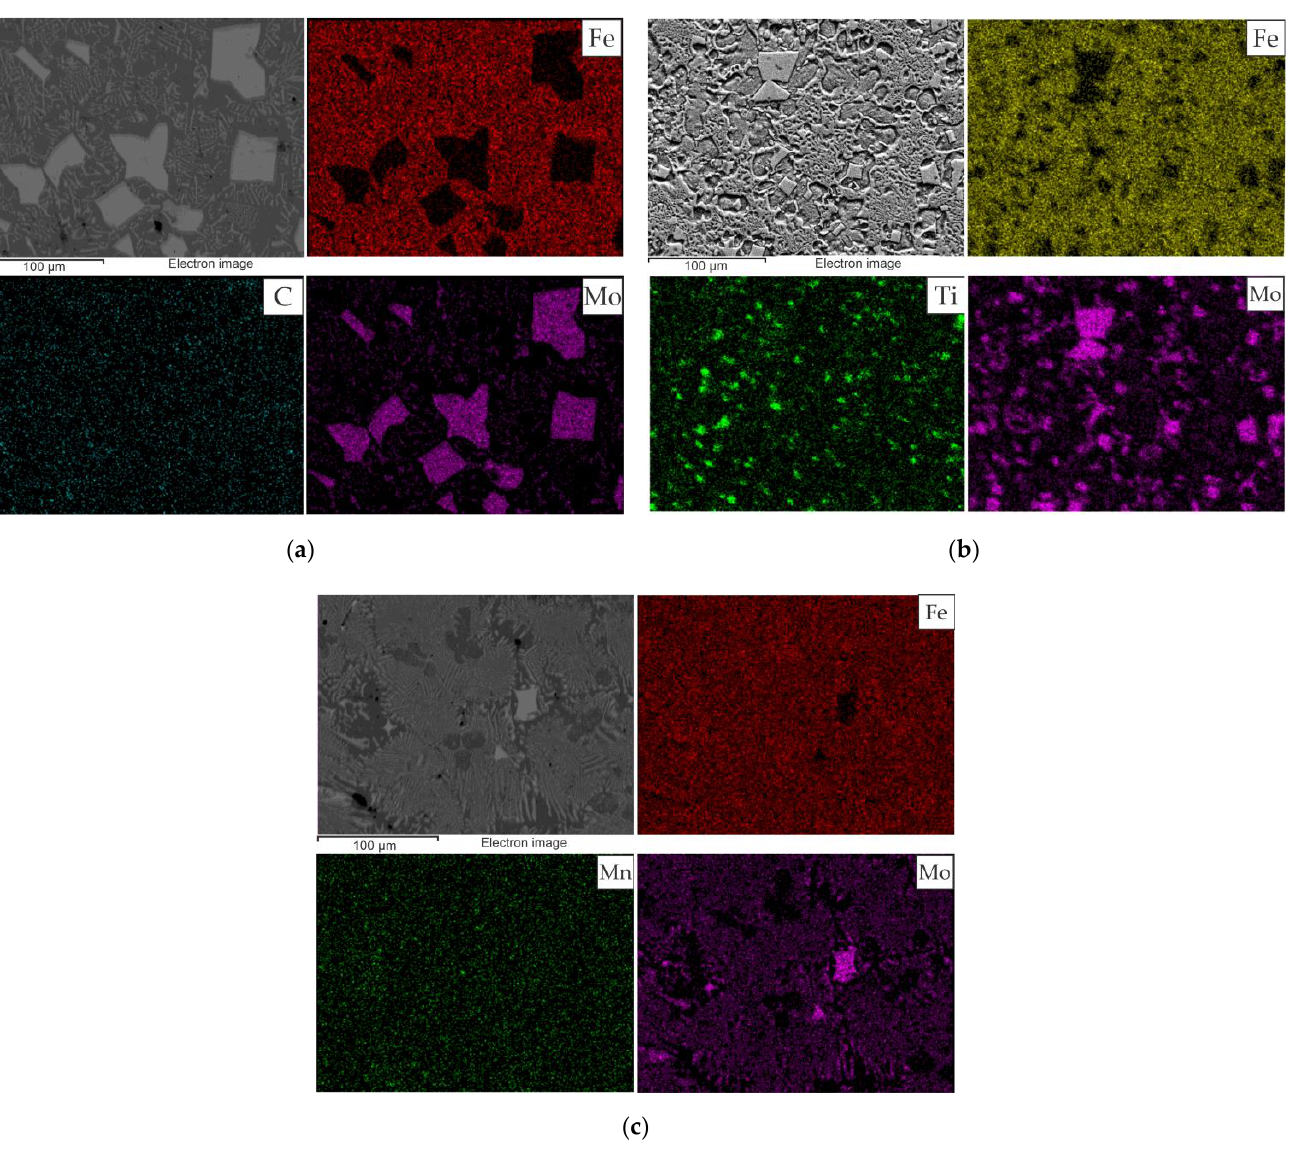
Figure 7. The EDS maps of the hardfacing layers: ( a ) Sample 1; ( b ) Sample 2; ( c ) Sample 3.